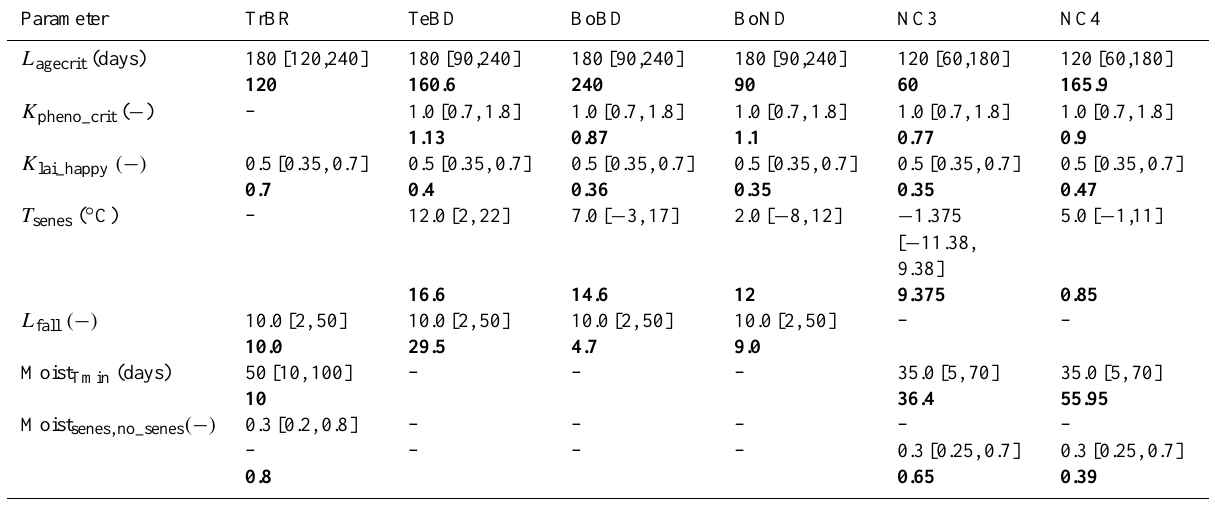
Table 2. ORCHIDEE parameters optimised. For each PFT the prior values, minimum and maximum values (in squared brackets) and multi- site posterior mean values (in bold) are given. Note the prior uncertainty on the parameters is defined as 40% of the full parameter range.